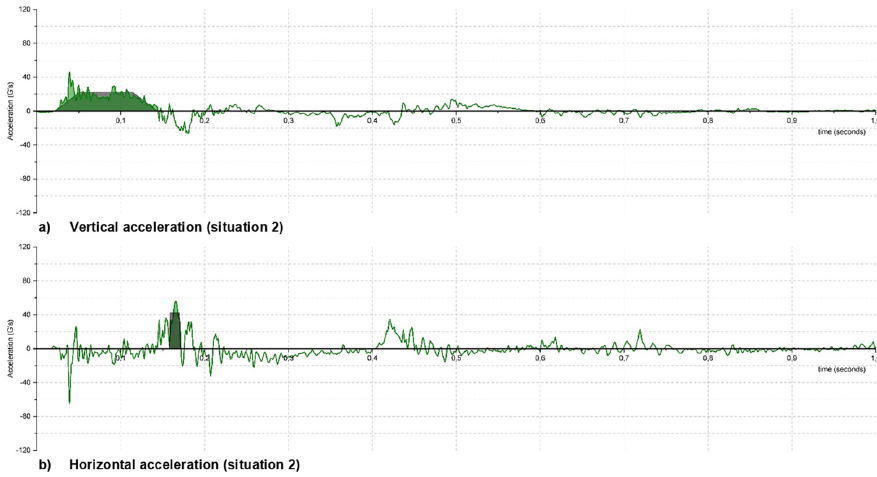
Figure 12. Critical acceleration pulses for the human